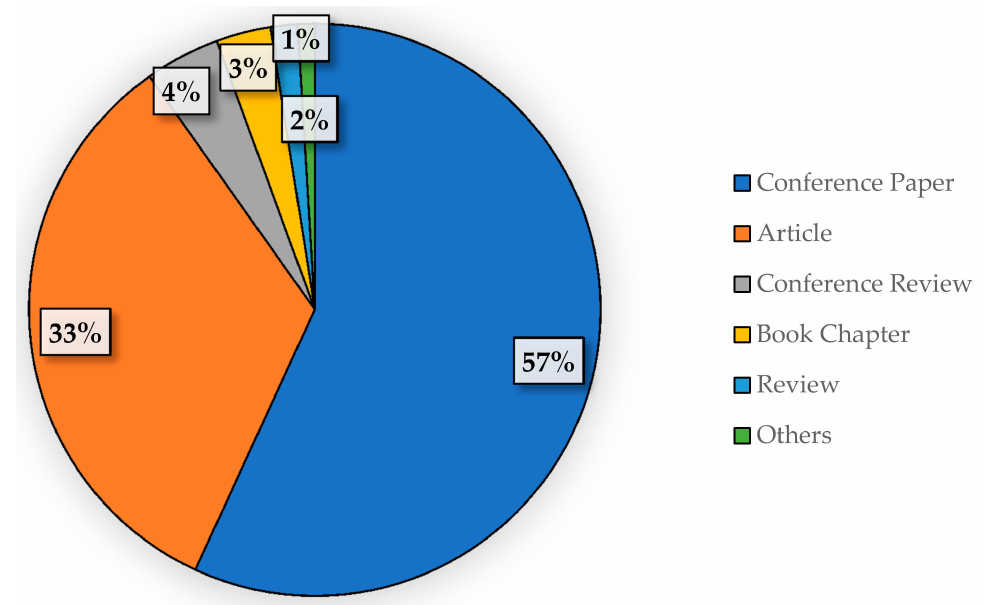
Figure 4. Publications in the DT research field by document